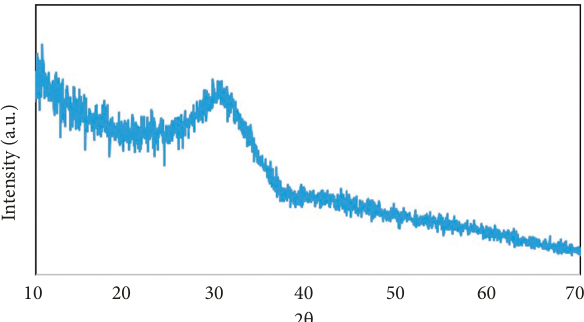
Figure 2: XRD pattern of 52S4 bioactive glass.